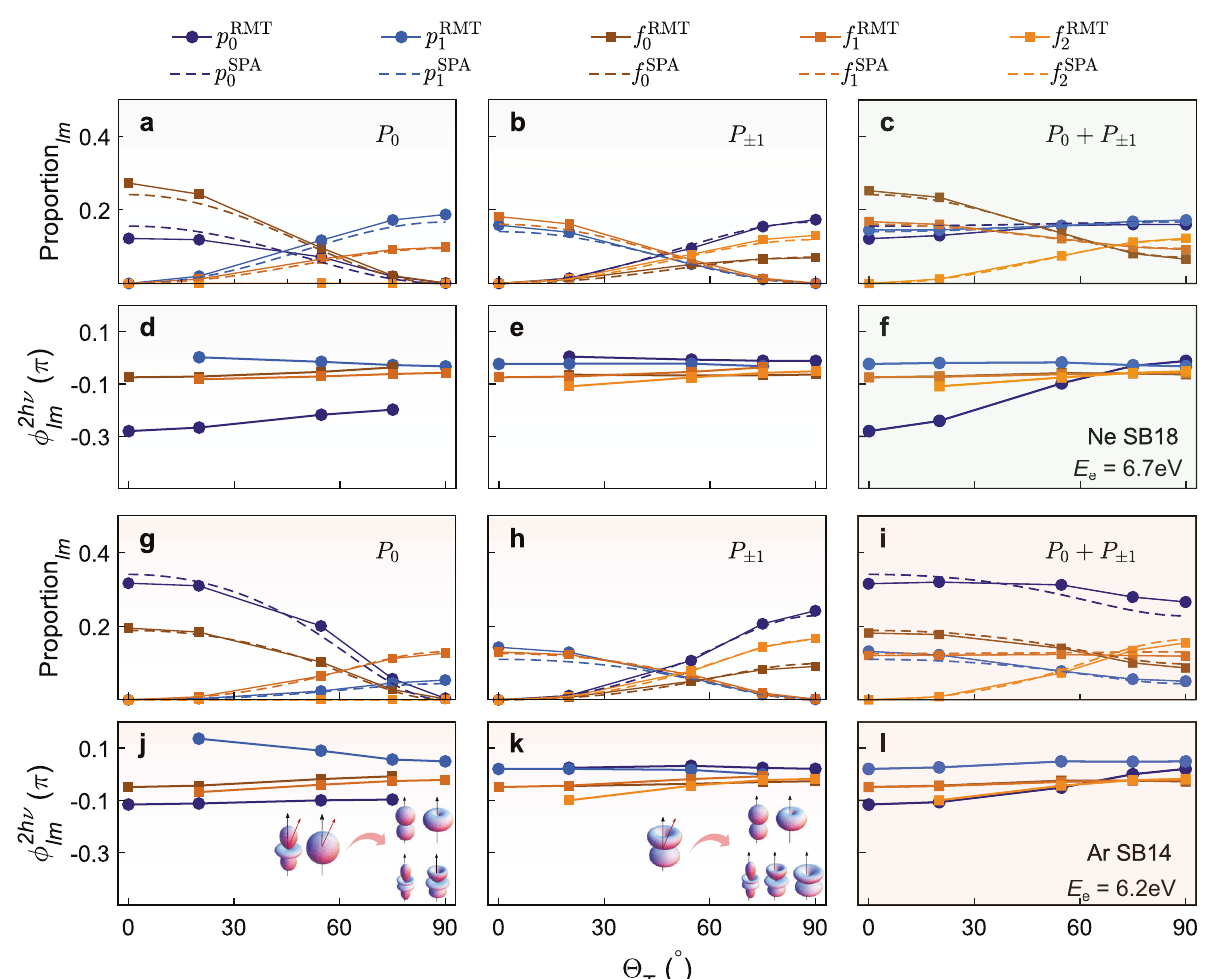
Fig. 4 | Full partial-wave analysis of neon and argon. a – c Partial-wave propor- tions(averagedoverallpump-probetime-delays)asafunctionof Θ T inneonforthe residualionicstatesof a P 0 , b P ±1 ,and c theincoherentsumof P 0 and P ±1 . d – f The m - resolvedtwo-photonphaseshiftsinneonforthesameinitialstatesas a – c .TheRMT